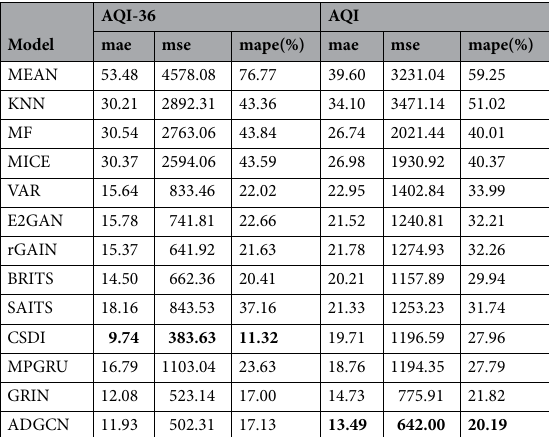
Table 2. Comparison of model performance for an average of 5 experiments filled on the air quality domain dataset. The best results are in bold.